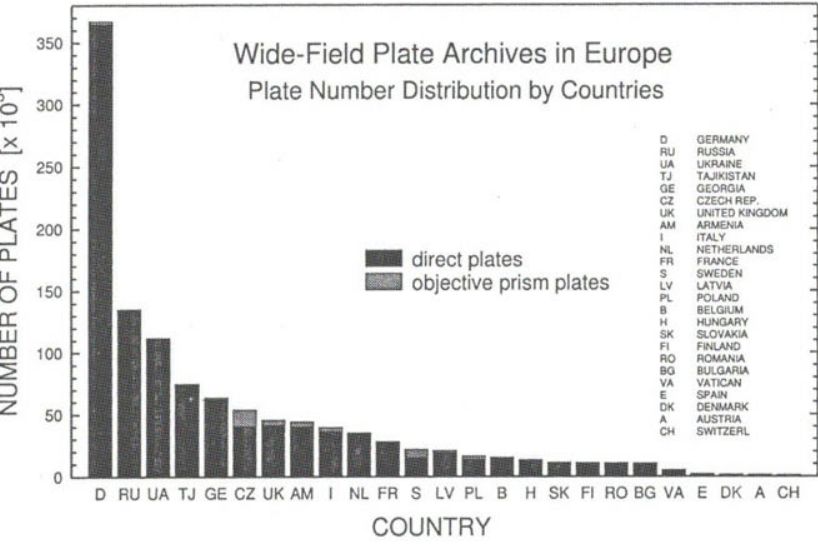
Fig. 3. Distribution of the number of wide-field plates in Europe by